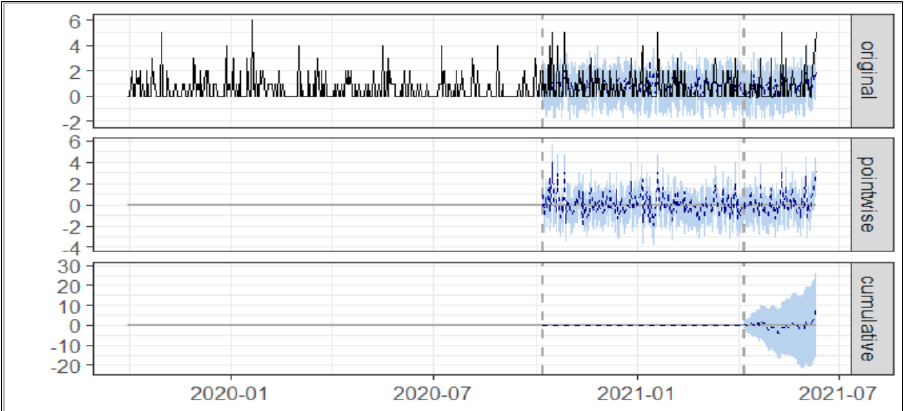
Figure 4. Trend of prescription of Asacol ® post intervention 1 and post intervention 2. Note: The first panel shows the data and a counterfactual prediction for the post-treatment period. The second